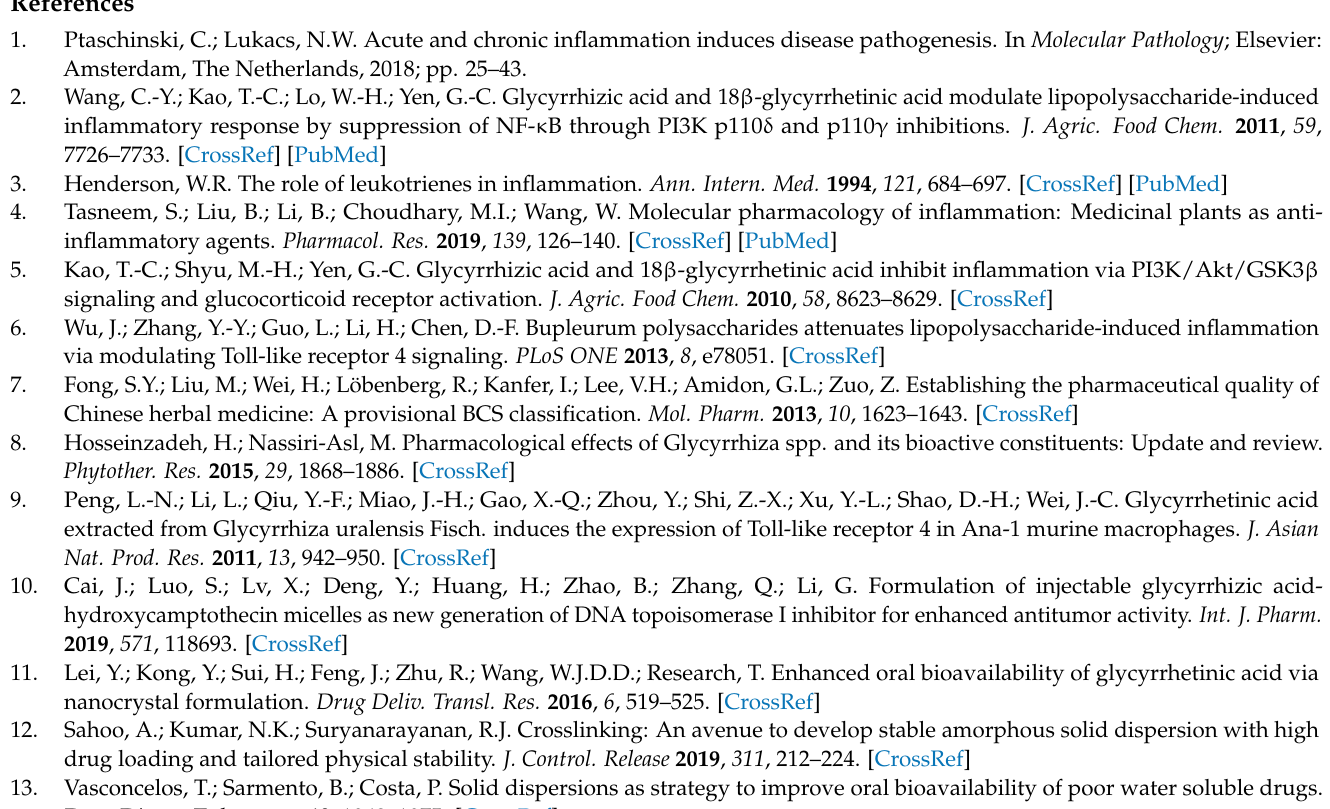
Figure S1. FT-IR analysis; Figure S2. Dissolution phenomena for 10 mg GA, GA-SD samples in 1 mL water; Figure S3. Macroscopic appearance of gastric